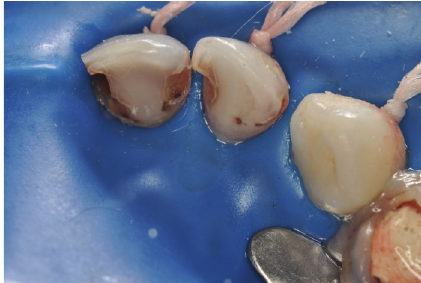
Figure 2: Radiographic image presenting periapical lesion and increased pericementary space.